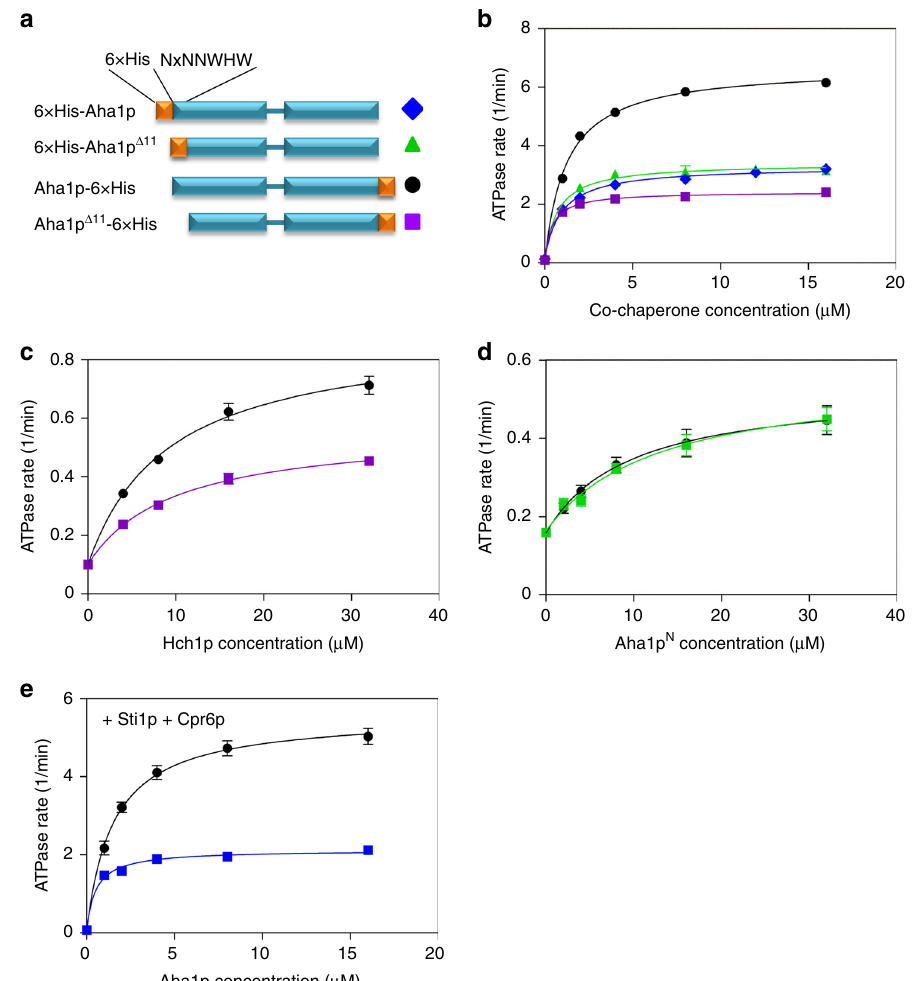
Fig. 3 Hsp90 ATPase stimulation by Aha1p and Hch1p. a Schematic of Aha1p constructs harboring N and C terminal 6xHis-tags. b Stimulation of the Hsp82p ATPase activity by increasing concentrations of Aha1p (N terminal 6xHis-tag — blue diamonds; C terminal 6xHis-tag — black circles) and Aha1p Δ 11 (N terminal 6xHis-tag — green triangles; C terminal 6xHis-tag — purple squares). Reactions contained 1 μ M Hsp82p and indicated concentration of co- chaperone ( n = 3). c Stimulation of the Hsp82p ATPase activity by increasing concentrations of Hch1p (black circles) and Hch1p Δ 11 (purple squares). Reactions contained 4 μ M Hsp82p and indicated concentration of co-chaperone ( n = 3). d Stimulation of the Hsp82p ATPase activity by increasing concentrations of Aha1p N (black circles) and Aha1p N- Δ 11 (green squares). Reactions contained 4 μ M Hsp82p and indicated concentration of co-chaperone ( n = 3). e Stimulation of the Sti1p-inhibited Hsp82p ATPase activity by increasing concentrations of Aha1p (black circles) and Aha1p Δ 11 (blue squares) in the presence of Cpr6p. Reactions contained 1 μ M Hsp82p, 4 μ M Sti1p, and 4 μ M Cpr6p ( n = 3). Error bars show standard error of the